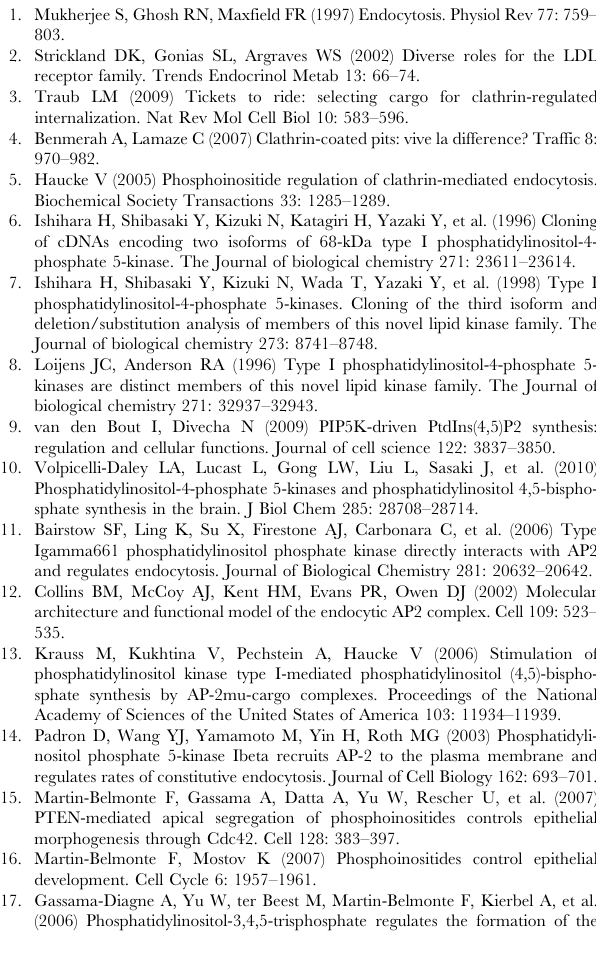
Table S1 Quantitation of clathrin coated structure distribution in MDCK cells. MDCK cells cultured on permeable supports were infected with control or PIP5KI b adenovirus and processed for electron microscopy. Clathrin coated structures were classified as shallow (type I), invaginated (type II), deeply invaginated (type III), or internalized and within one micron of the plasma membrane (type IV). Listed are the total number of clathrin coated structures counted of each type and the total length of membrane